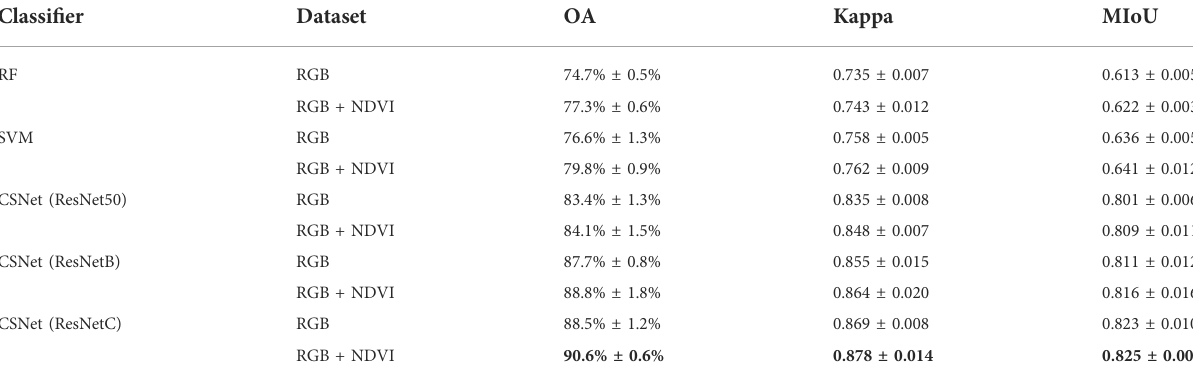
TABLE 4 Over accuracy, kappa averaged (±one standard deviation) and MIoU for every classi fi